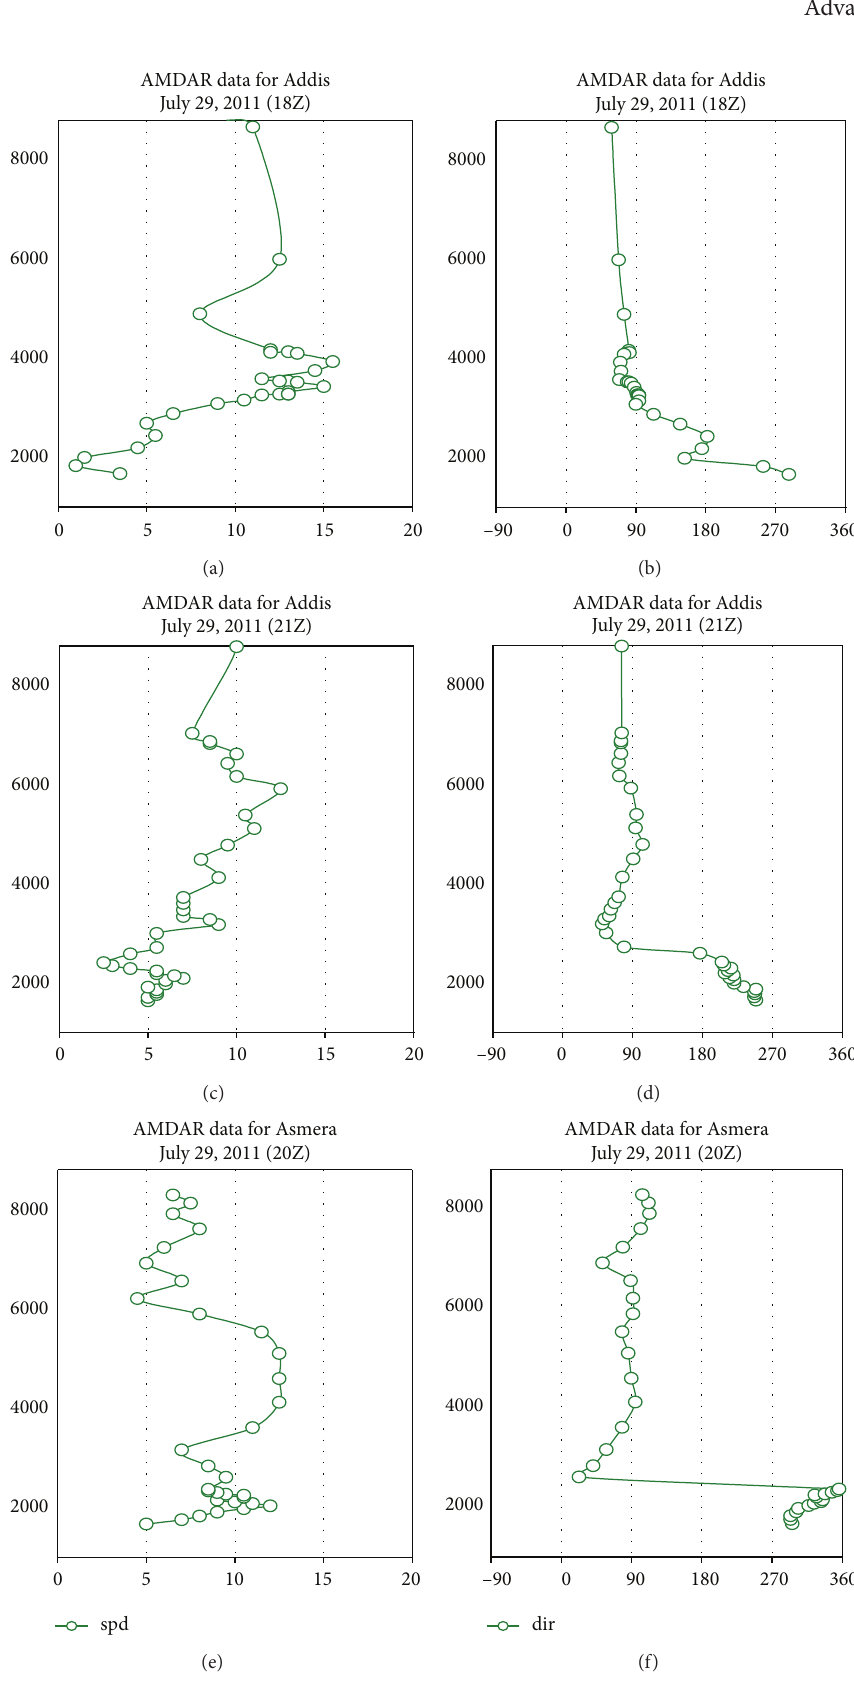
Figure 5: AMDAR aircraft wind profiles for evening of 29 July, 2011 (height—m,